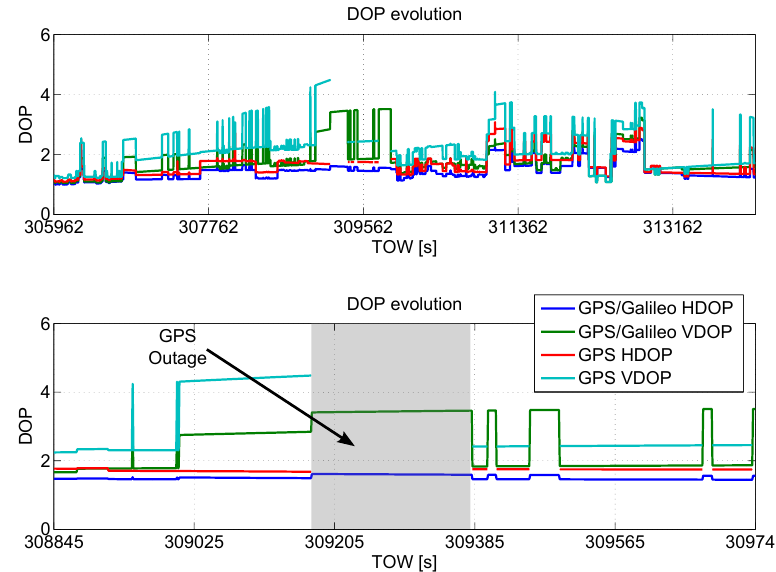
Figure 2. Horizontal dilution of precision (HDOP) and vertical dilution of precision (VDOP) of the configurations without the receiver autonomous integrity monitoring (RAIM) application as a function of